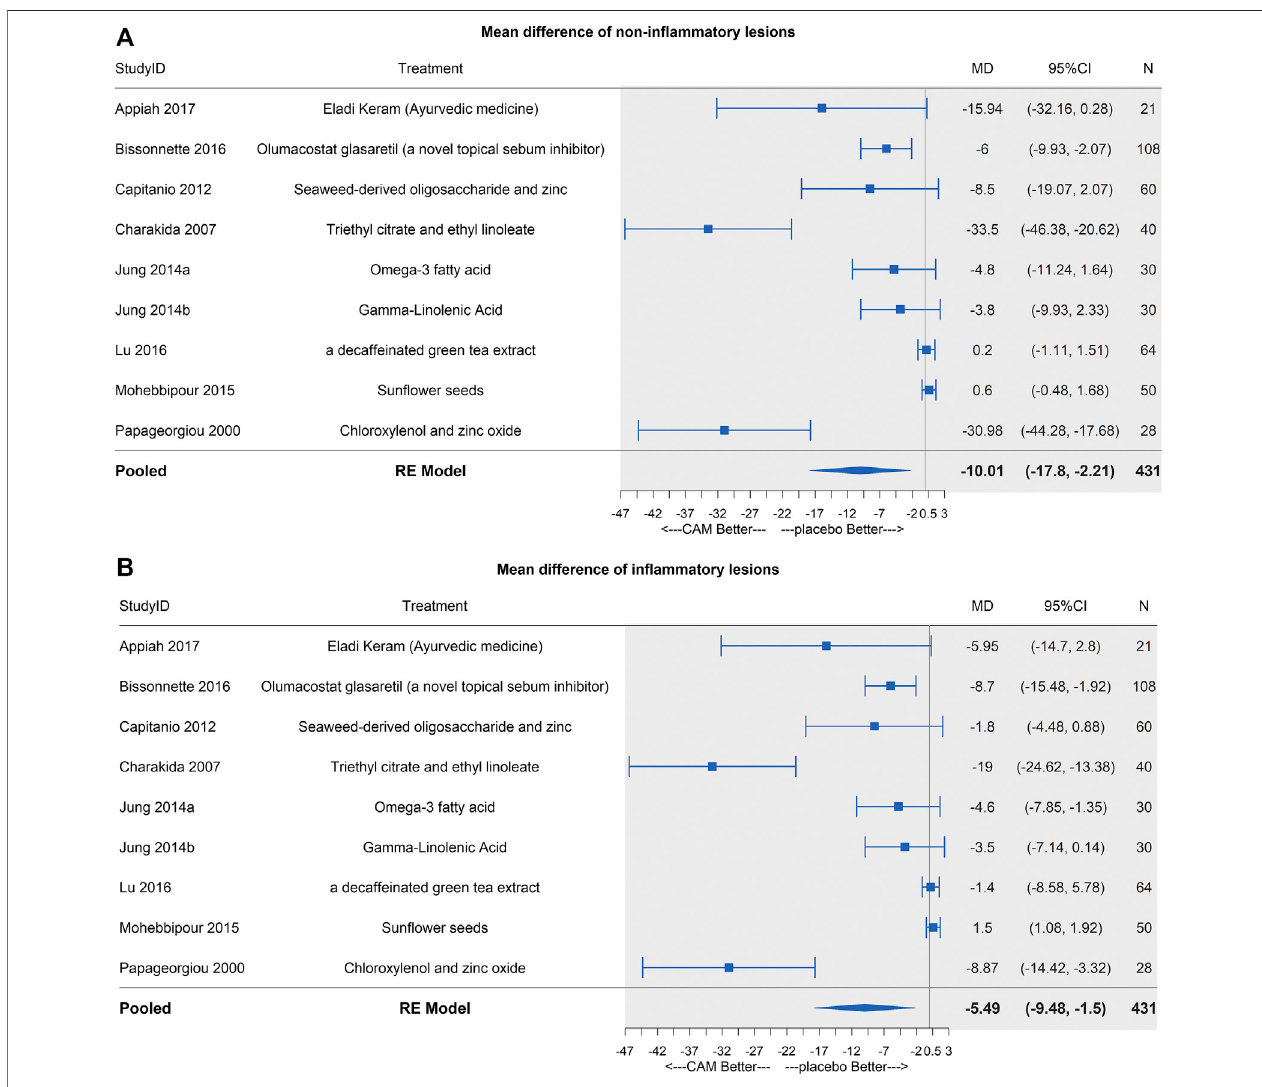
FIGURE 6 | Forest plots of MTCAM vs. placebo. (A) Mean difference of nonin fl ammatory lesions count. (B) Mean difference of in fl ammatory lesions count.